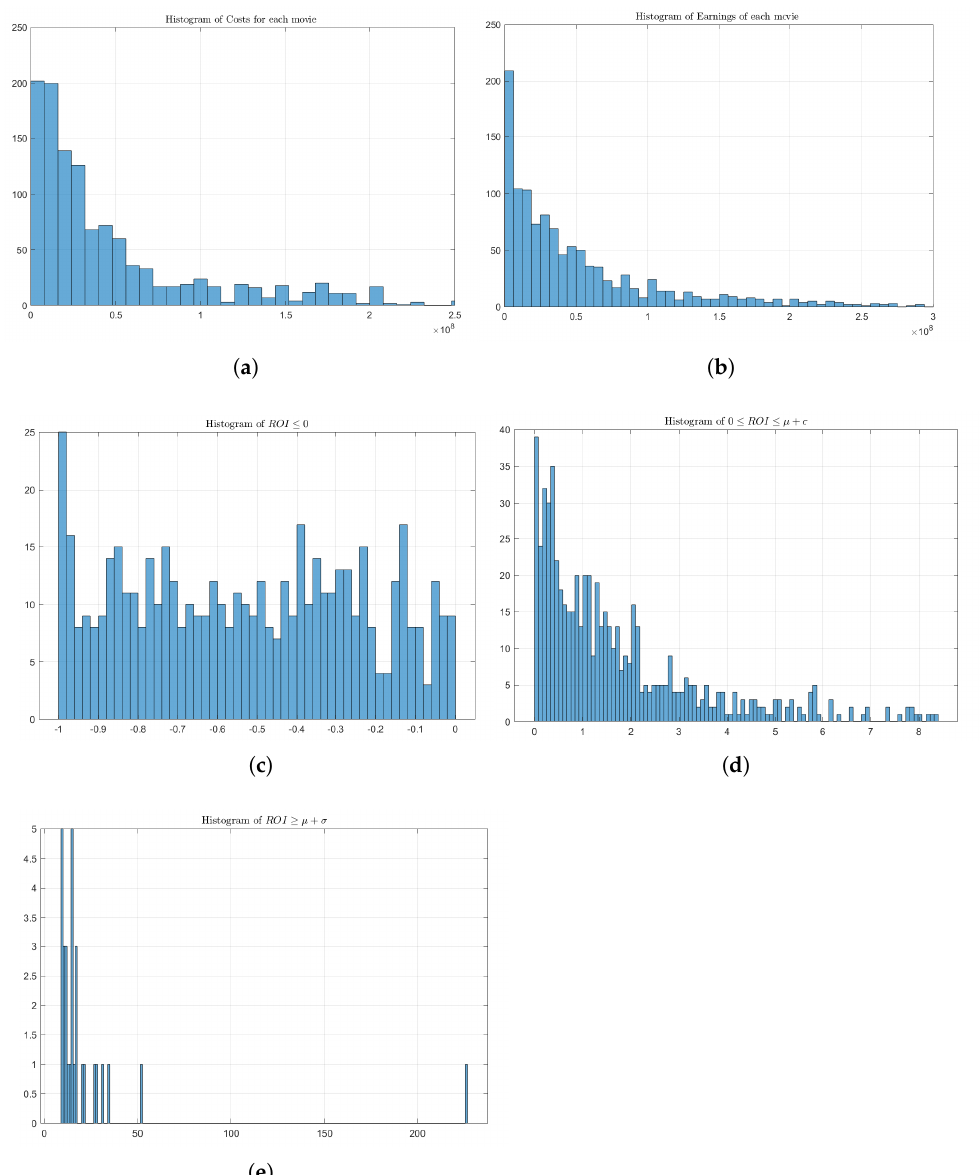
Figure 2. Histograms of C and Y , panels ( a , b ), and histogram of ROI for the three partitions, panels ( c – e